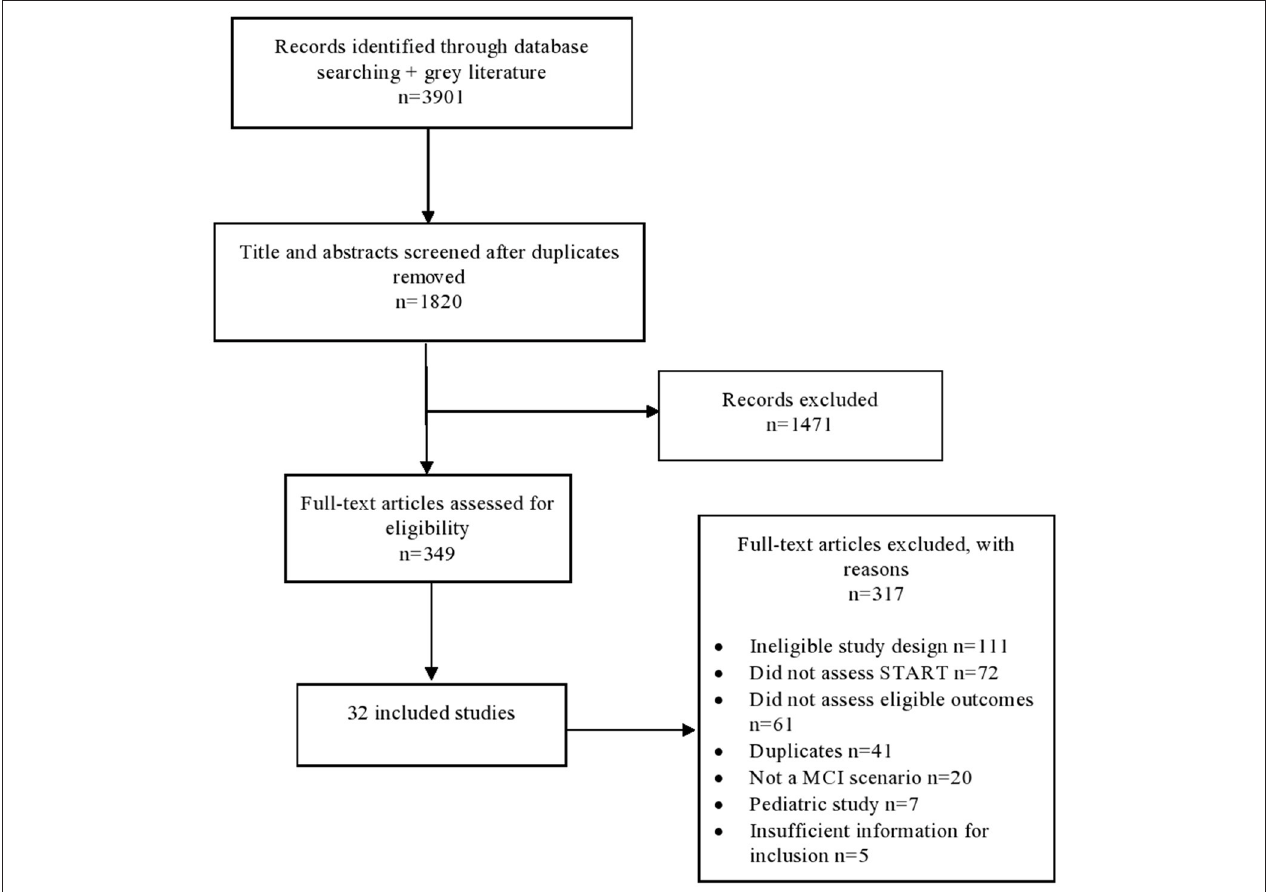
FIGURE 1 | Literature search flow